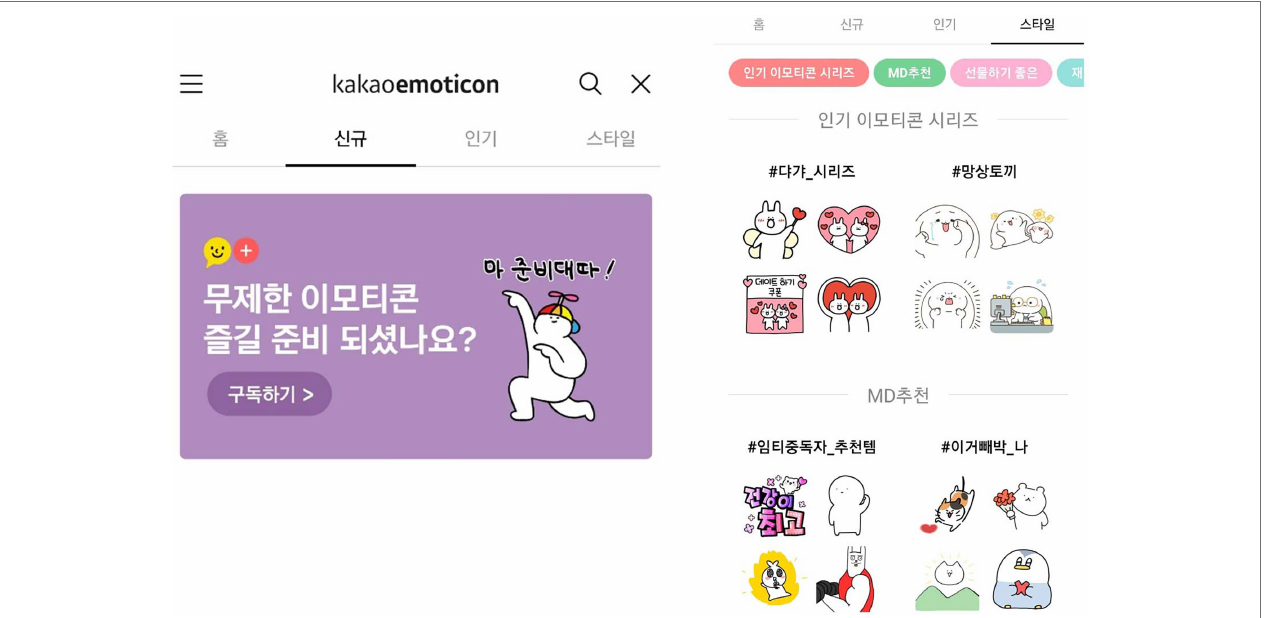
FIGURE 1 | Kakao emoticon shop and example of stickers. Images reproduced with permission of